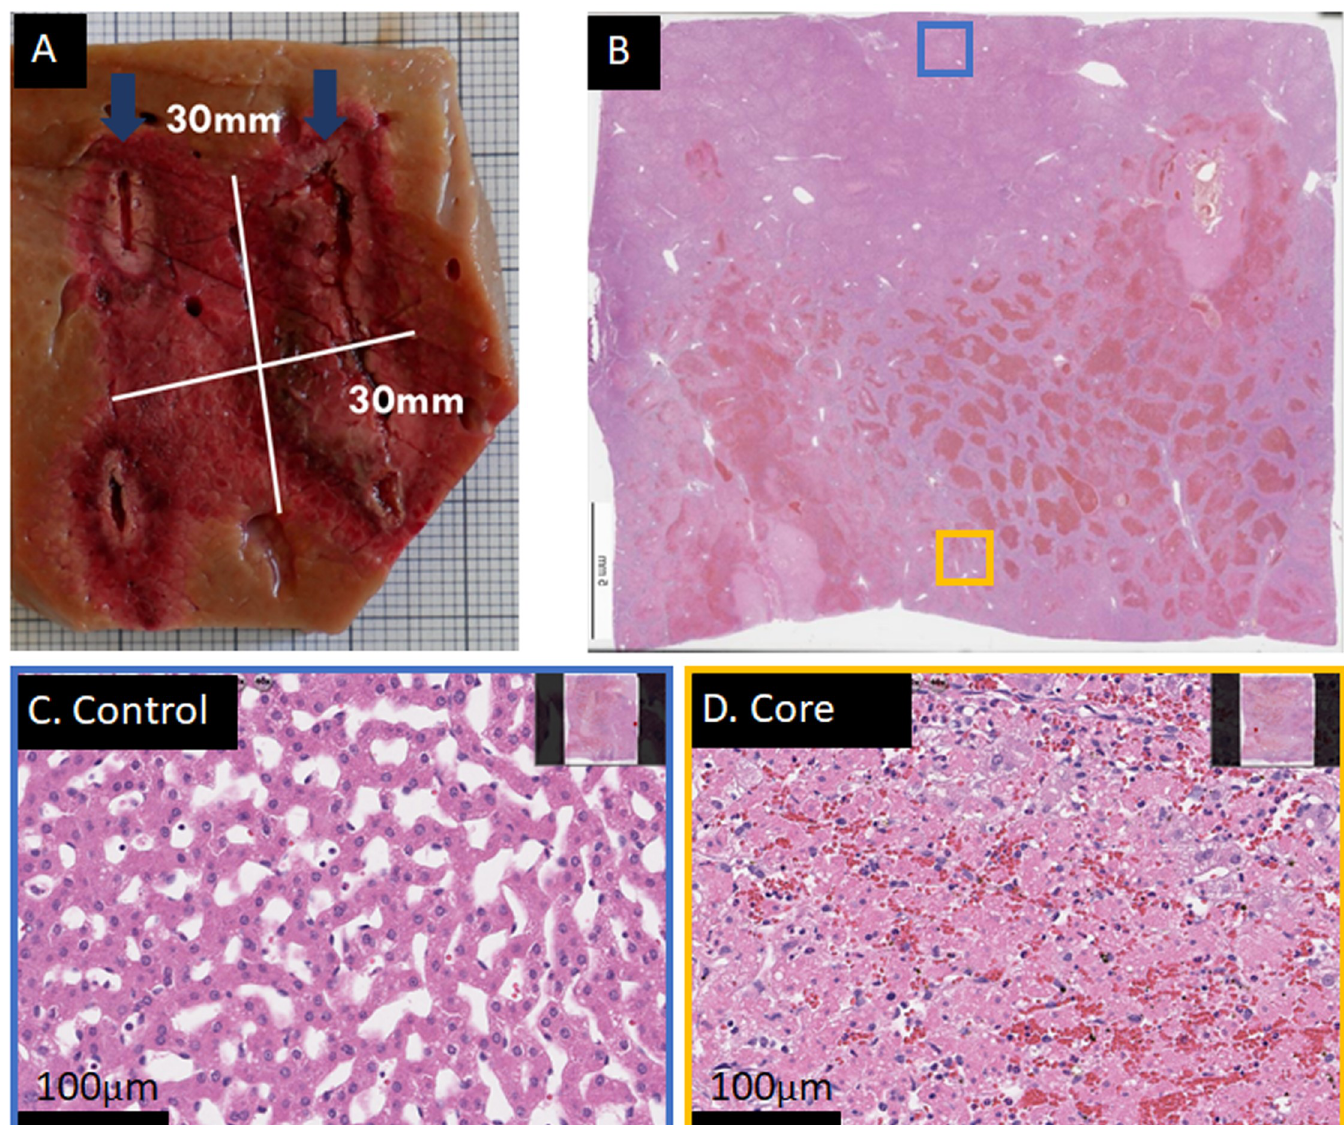
Fig 4. Successful 2-electrode ablation. There was a distance of 20mm between the electrodes, with an exposed length of 30mm and custom-made electrodes of 18G diameter, using 2 waveforms of 1500V peak voltage. Total time required was approx. 5s. Liver was harvested 23h post treatment. (A) The outline of the macroscopic coronal cut, showing the area between the electrodes. Dark blue arrows indicate direction of electrode track. (B) H&E staining of the upper part of the lesion. (C) H&E stained control area at 20x magnification, blue insert in B. (C) H&E stained area at 20x magnification from the core region (yellow insert in B). Severe cell death is found throughout the lesion. Note that the sample was cut out of plane, hence there is no perfect match between macroscopic and microscopic